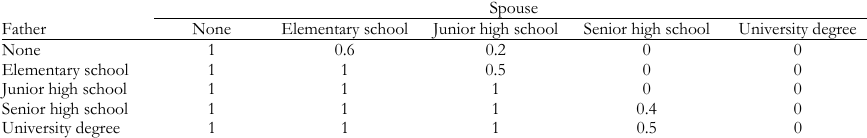
Educational achievement of the household spouse and her/his